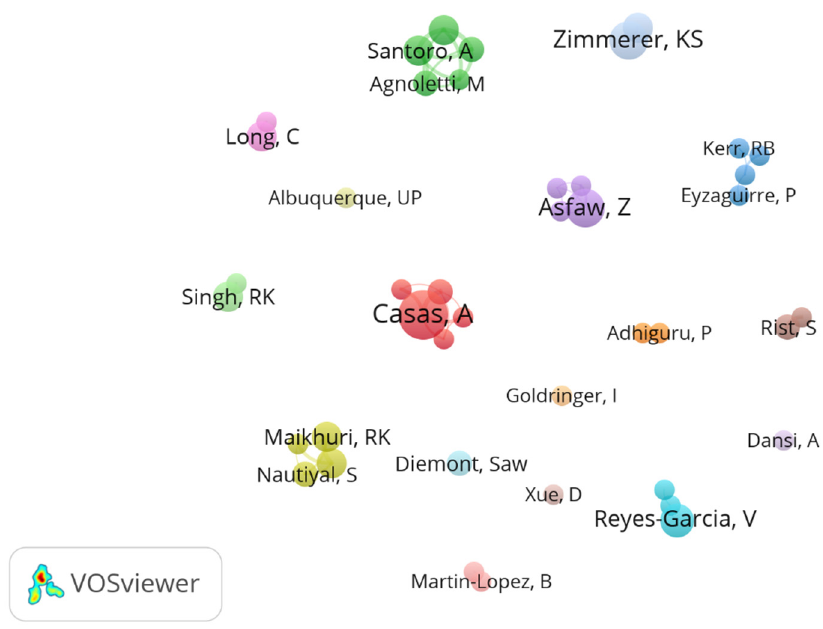
Figure 4. The collaboration network of authors about the agrobiodiversity and traditional knowledge.